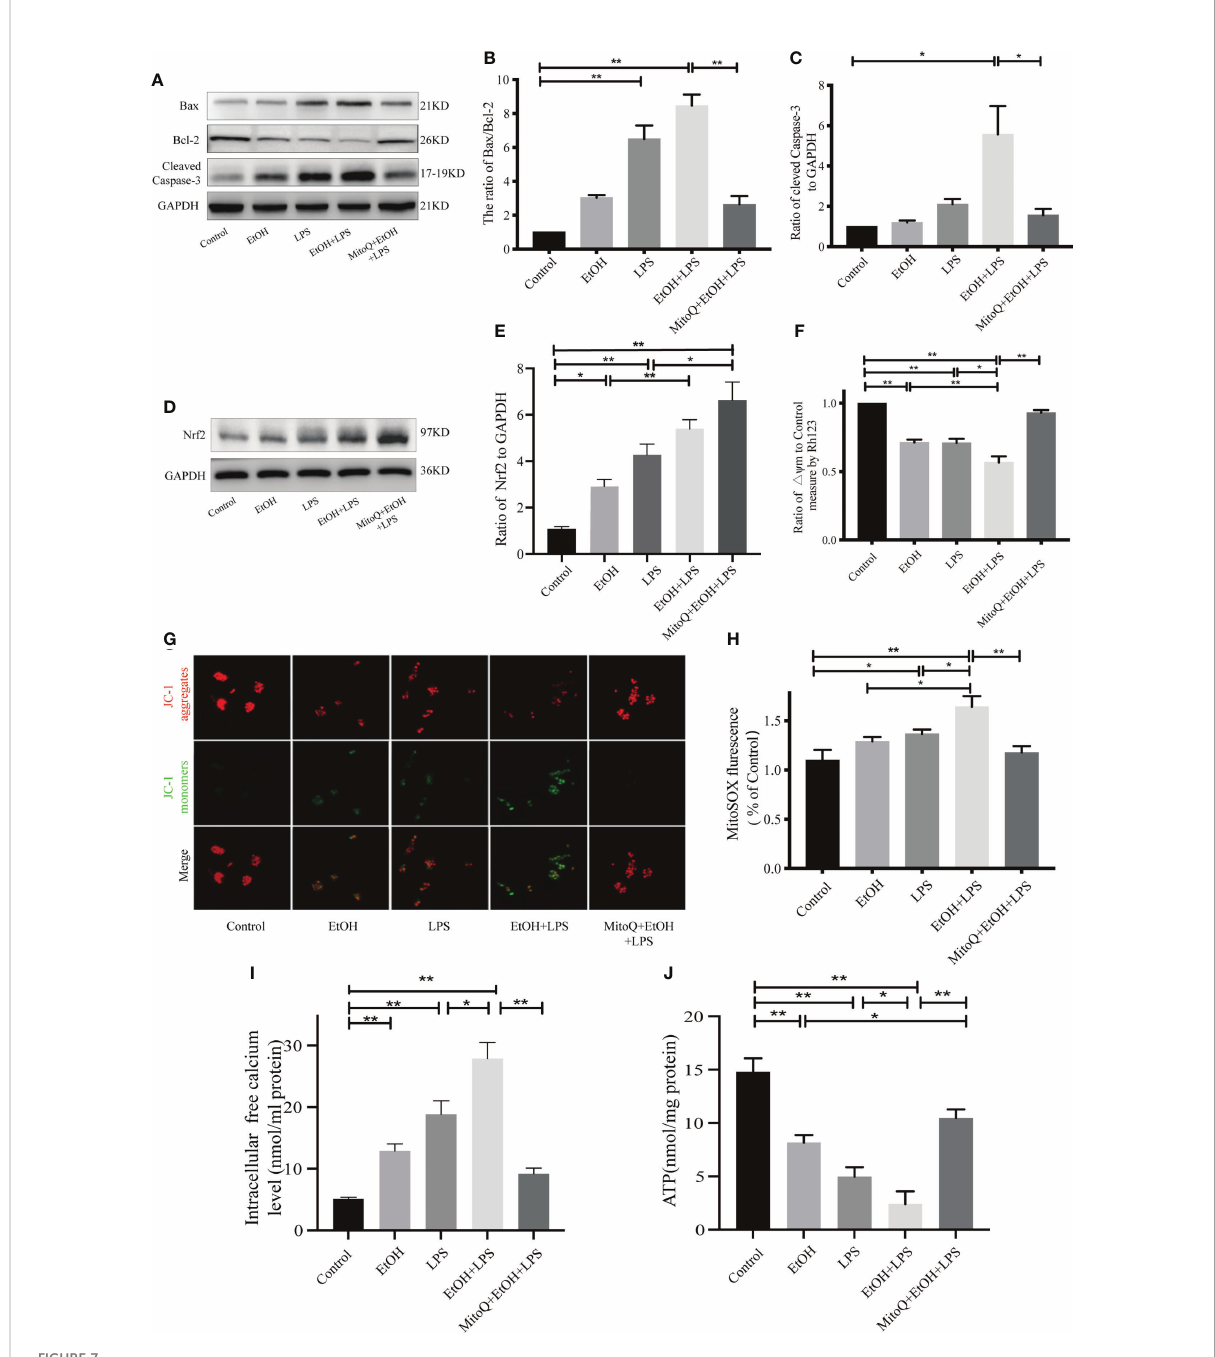
FIGURE 7 MitoQ protected mitochondria injury in Raw264.7 cells induced by ethanol and LPS. (A – C) Protein levels of Bax, Bcl-2, and Cleaved Caspase-3 were detected by western blotting. (D, E) Protein levels of Nrf2 were detected by western blotting. (F) Mitochondrial membrane potential ( DY m) was evaluated by Rho123 fl uorescence analysis. (G) Mitochondrial membrane potential in Raw264.7 cells were analyzed by JC-1 staining (400×). Red staining indicates polarized mitochondria in JC-1 staining. Green staining indicates depolarized mitochondria in JC-1 staining. (H) Mitochondrial ROS was analyzed by fl uorescence microplate. (I) Intracellular free calcium level was measured using Fura-2/AM in cultures by microplate reader. (J) Cellular ATP concentrations were detected in Raw264.7 cells by microplate reader. All data were presented as mean ± SEM (n=5 in each group), *P < 0.05, **P <